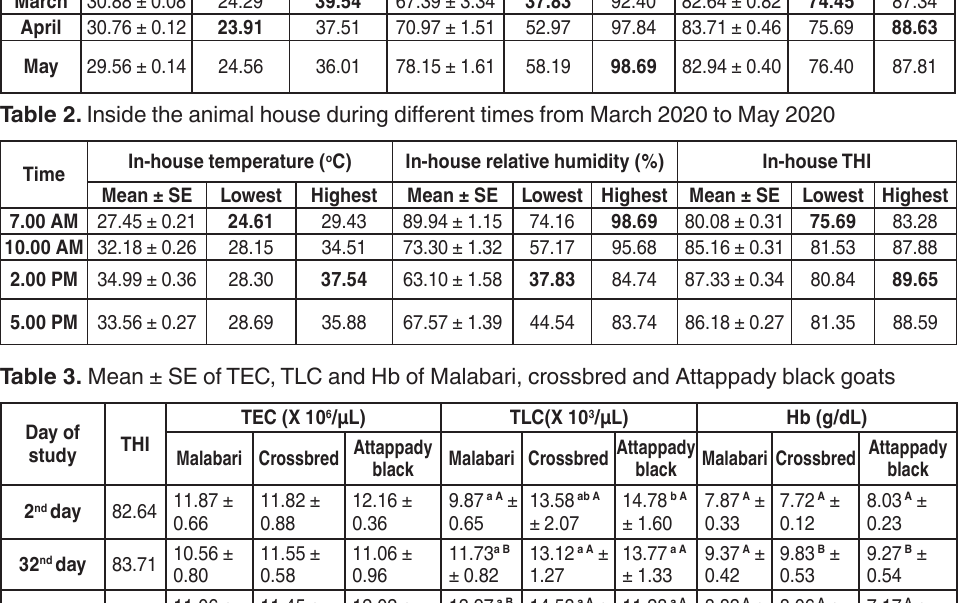
table 1. Inside the animal house during March 2020 to May 2020 Period